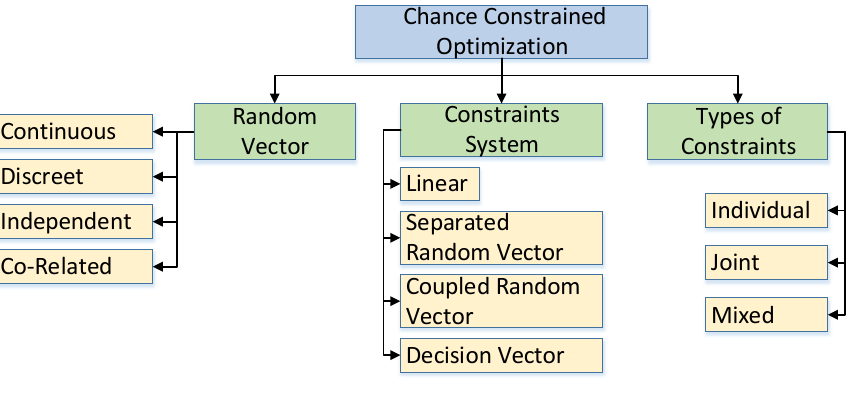
Figure 6. Taxonomy of chance constrained